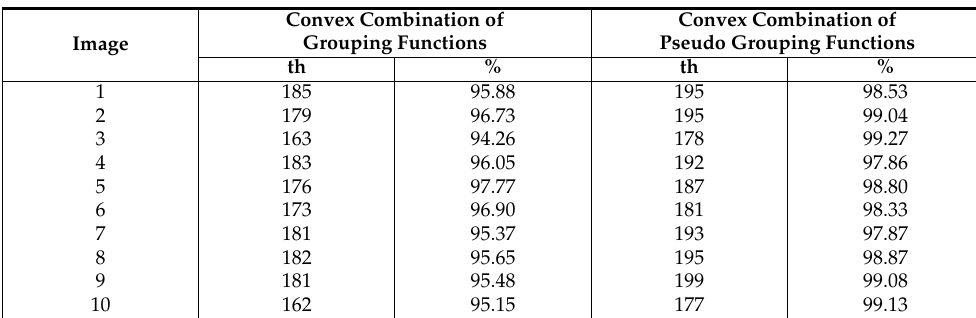
Table 13. Thresholds and percentages obtained from convex association of grouping functions and convex association of pseudo grouping